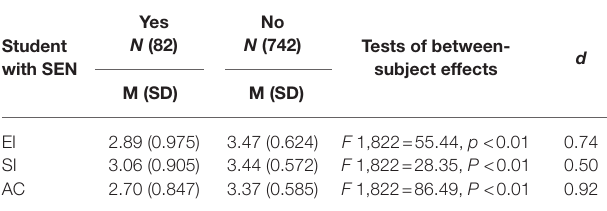
TABLE 2 | Differences in the perceived levels of inclusion based on whether students have